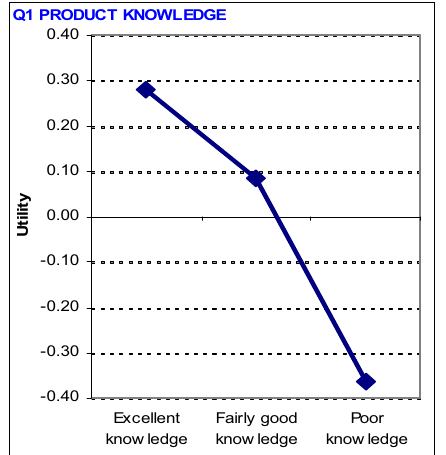
Fig. 3. Consumer perceptions about salesperson